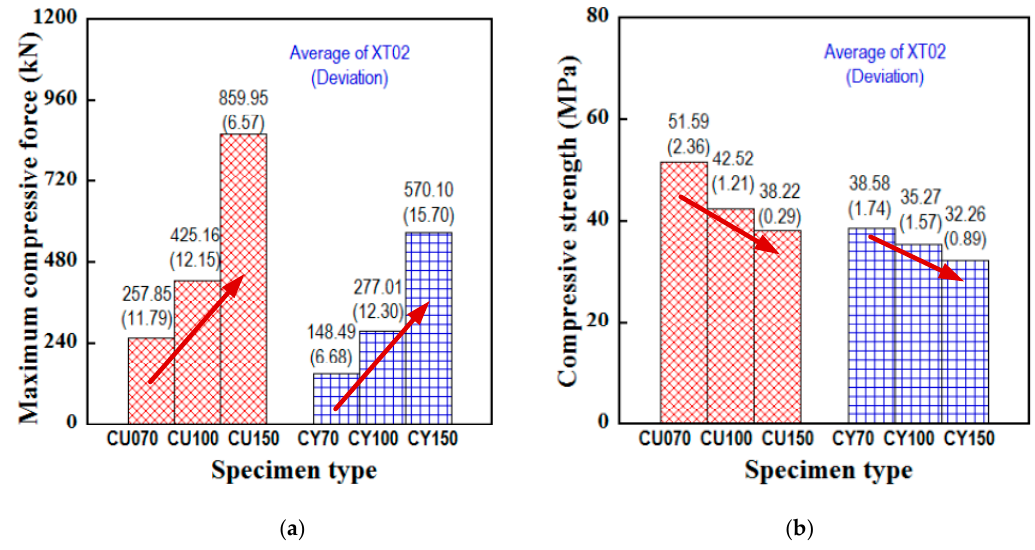
Figure 9. Dependence of compressive strength at the 28-day age upon specimen size and shape of the XT02. ( a ) Peak compressive force. ( b ) Peak compressive strength.